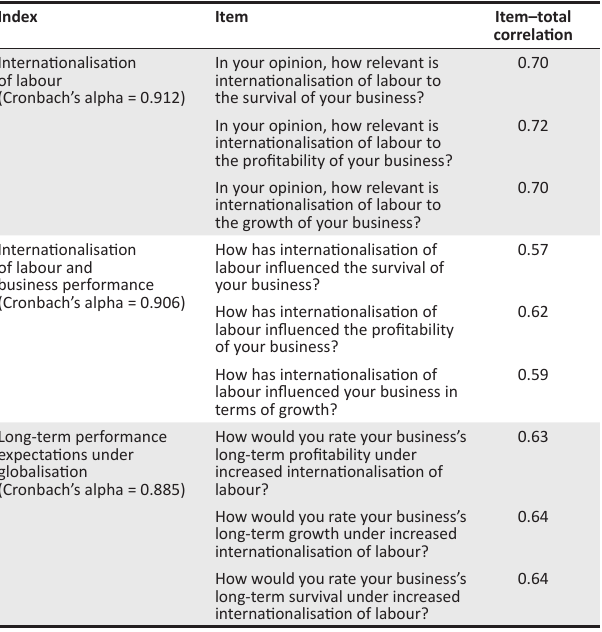
TABLE 1: Cronbach’s alpha coefficients and item–total for each of the three